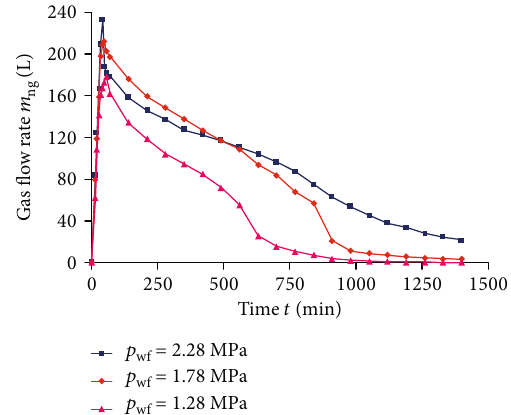
Figure 9: The e ff ect of bottom-hole pressure of the production wellbore on o ff shore natural gas fl ow rate in 3-D marine sediments under